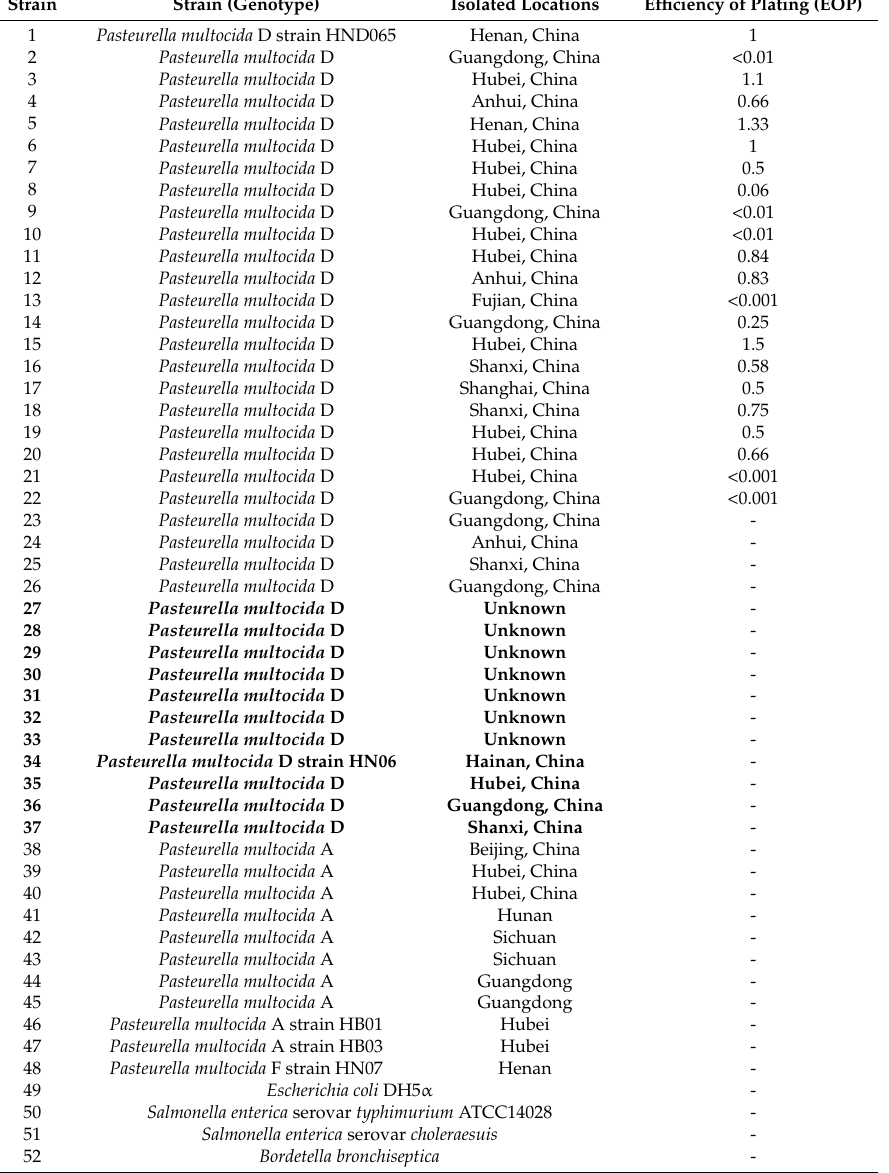
Table 1. Host range of phage PHB01 1